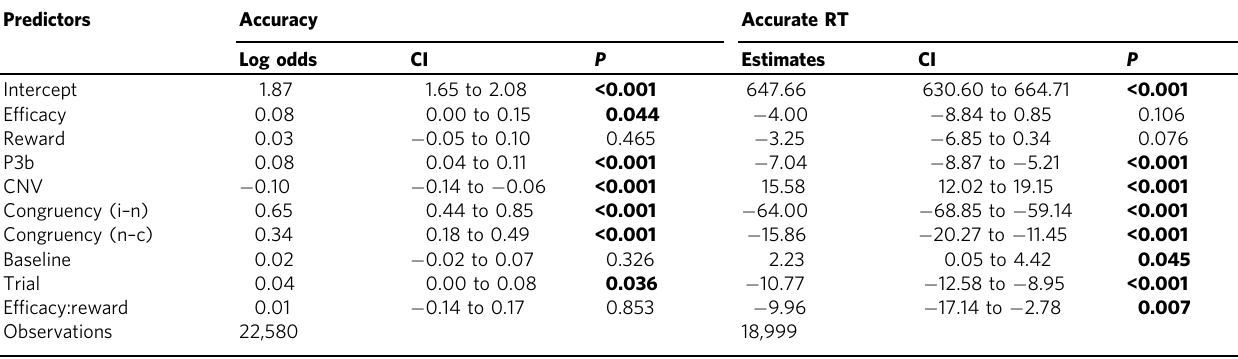
Table 2 Effects of neural signals on behavioral performance.